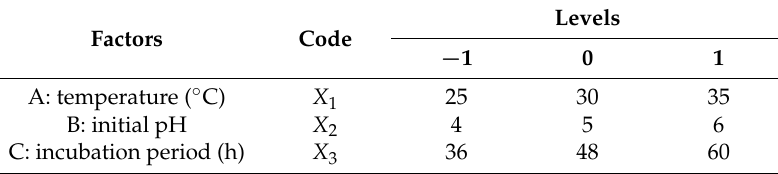
Table 4. Factors and levels in response surface